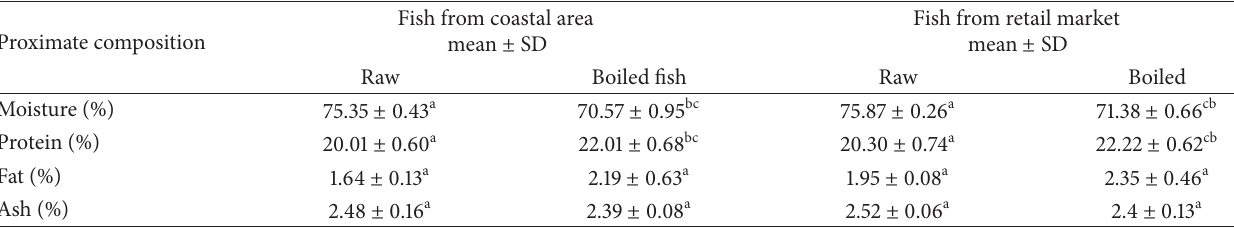
Table 3: Effects of sampling location and boiling on proximate composition in the silver pomfret fish